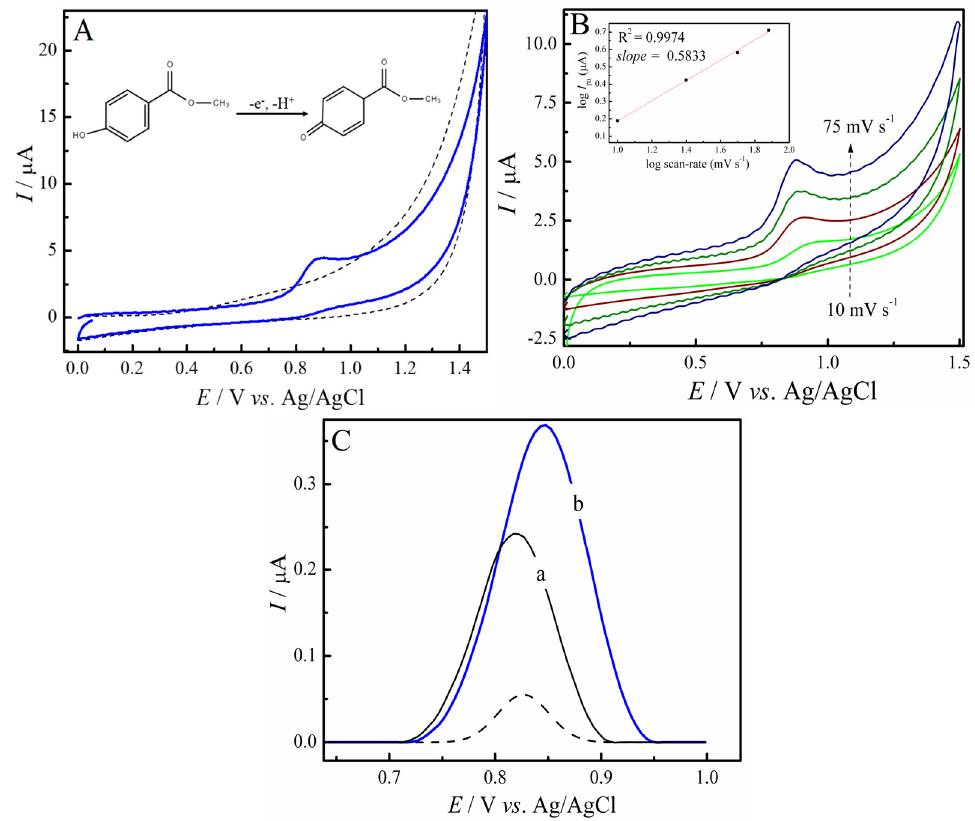
Figure 2. ( A ) Cyclic voltammetry at GC/RC-SbNP electrode in 0.1 mol L − 1 PBS (pH 7.0) solution in the absence (dashed line) and presence (solid line) of 100 µmol L − 1 MePa. ( B ) Cyclic voltammetry at GC/RC-SbNPs in 0.1 mol L − 1 PBS (pH 7.0) in the presence of 100 µmol L − 1 of dopamine, evidencing a linear increase for anodic peak in the function of the increase of scan rate. ( C ) Differential pulse voltammograms in 0.1 mol L − 1 PBS pH 7.0 solution added to 10.0 µmol L − 1 of MePa for GC electrode (dash line), GC/RC electrode (a) and GC/RC-SbNP electrode (b).